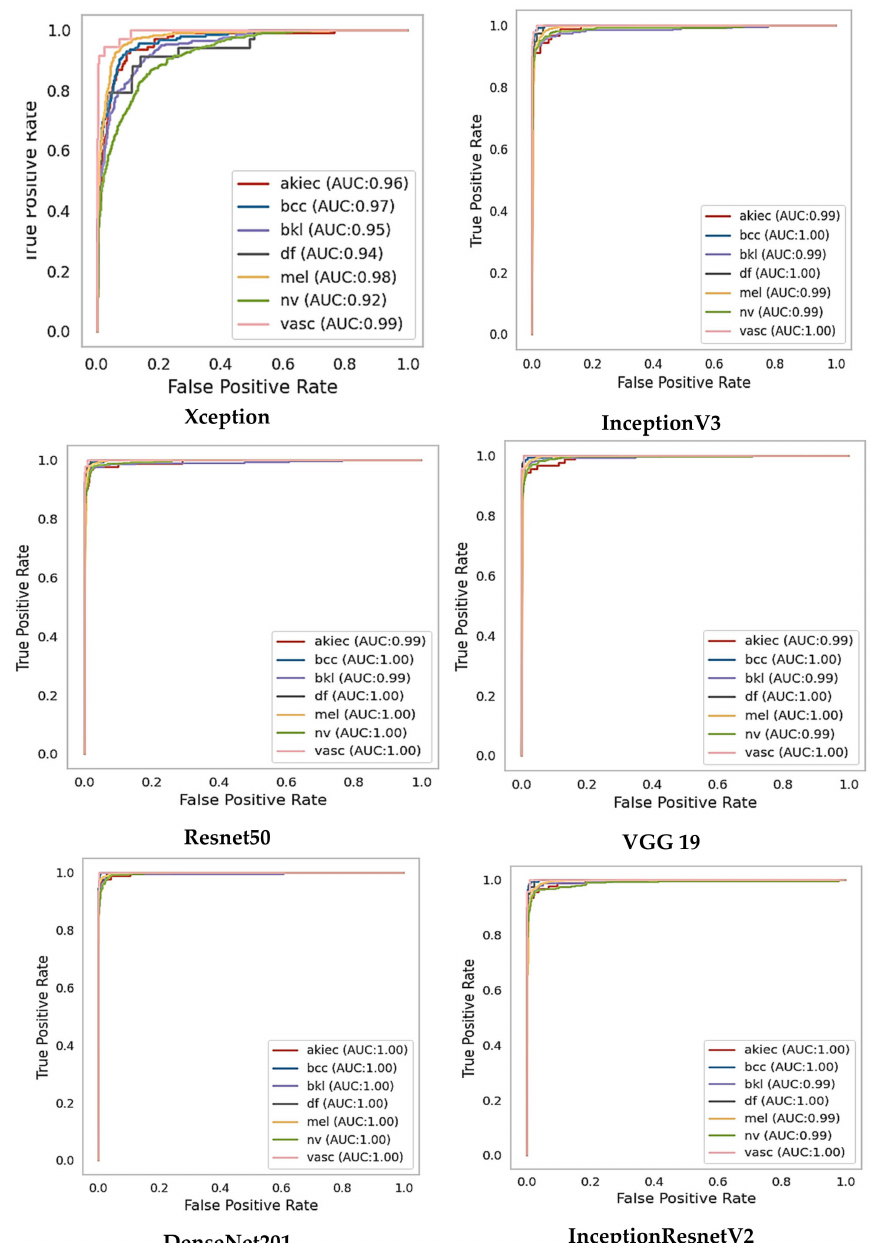
Figure 4. The ROC curves for the deep learning